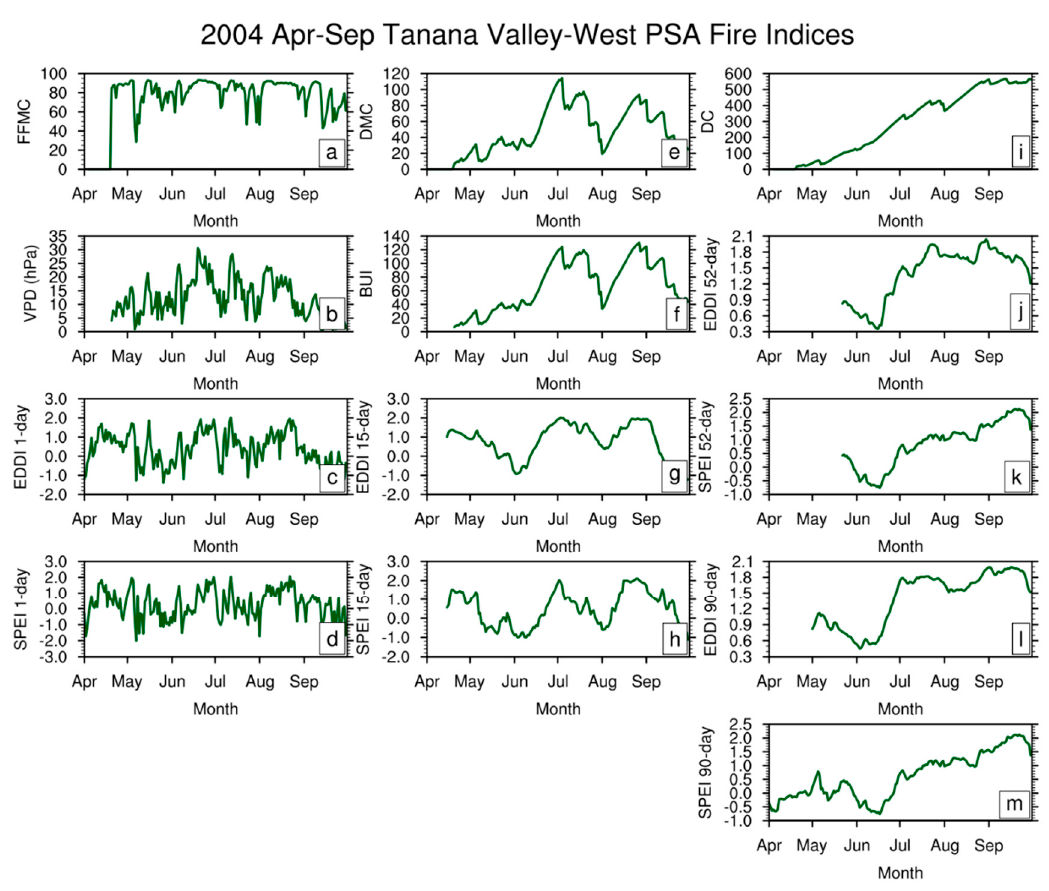
Figure 6. Time series for 2004 for the fire indices from 1 April to 30 September 2004 for the area around Fairbanks. ( a ) FFMC, ( b ) VPD, ( c ) EDDI 1-day, ( d ) SPEI 1-day, ( e ) DMC, ( f ) BUI, ( g ) EDDI 15-day, ( h ) SPEI 15-day, ( i ) DC, ( j ) EDDI 52-day, ( k ) SPEI 52-day, ( l ) EDDI 90-day, and ( m ) SPEI 90-day.